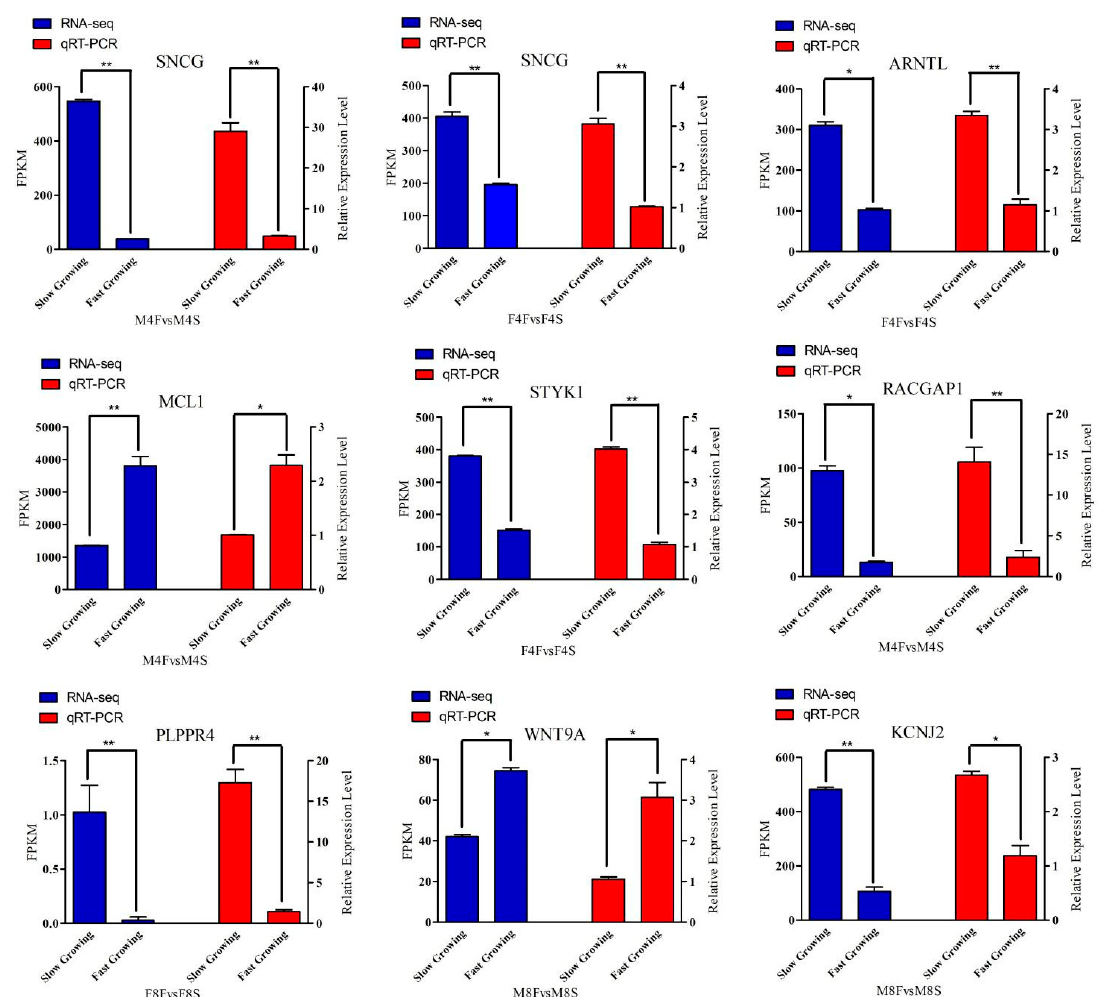
Figure 7. Expression level of eight DEGs detected by RNA-Seq and qRT-PCR. “*”: 0.01 ≤ p < 0.05; “**”: p < 0.01.